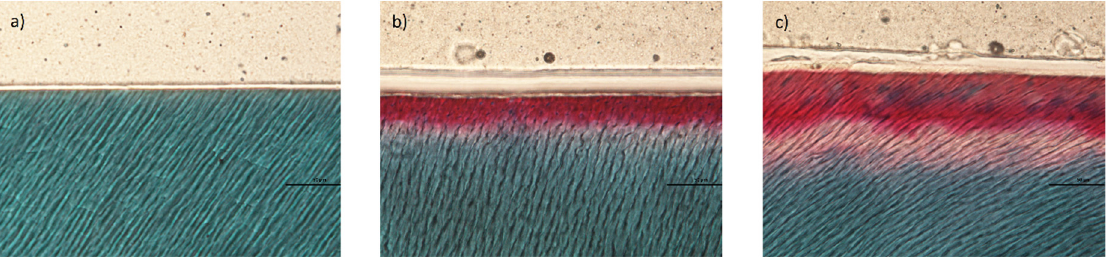
Figure 8. Masson’s trichrome images: ( a ) sound dentine, ( b ) pHc (14 days), and ( c ) pHc (28 days). The red band indicates demineralised collagen type I. Scale bar: 50 µm.